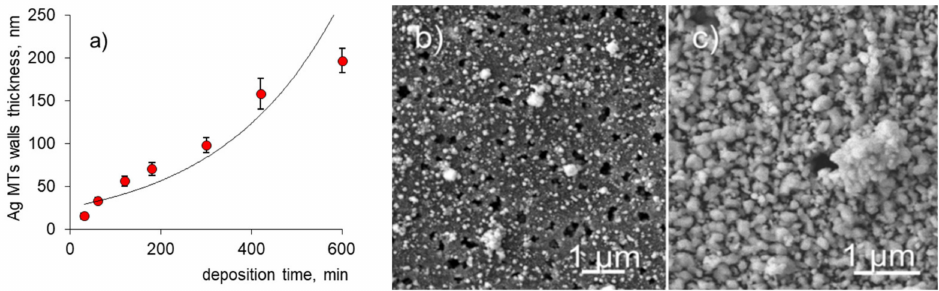
Figure 1. The change in wall thickness of silver microtubes (MTs) depending on the deposition time